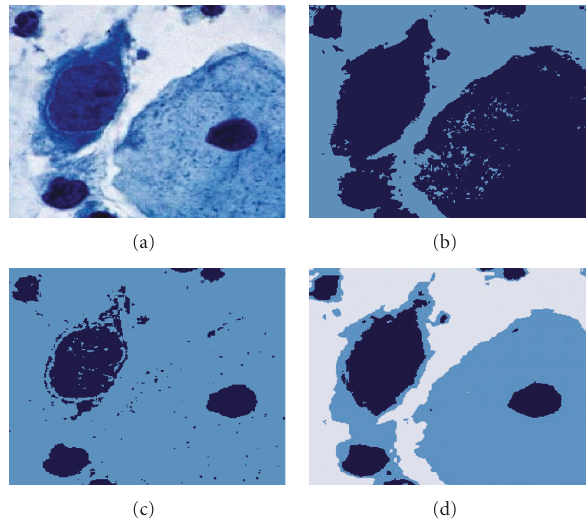
Figure 7: Comparison of the proposed segmentation method with other existing methods on a complex medical image (3 classes, various cells). (a) Original image (256 × 256 × 3): colour cells image with RGB description, (b) segmentation based on HCM and DS, (c) segmentation based on FCM and DS, and (d) segmentation based on homogeneity and DS.